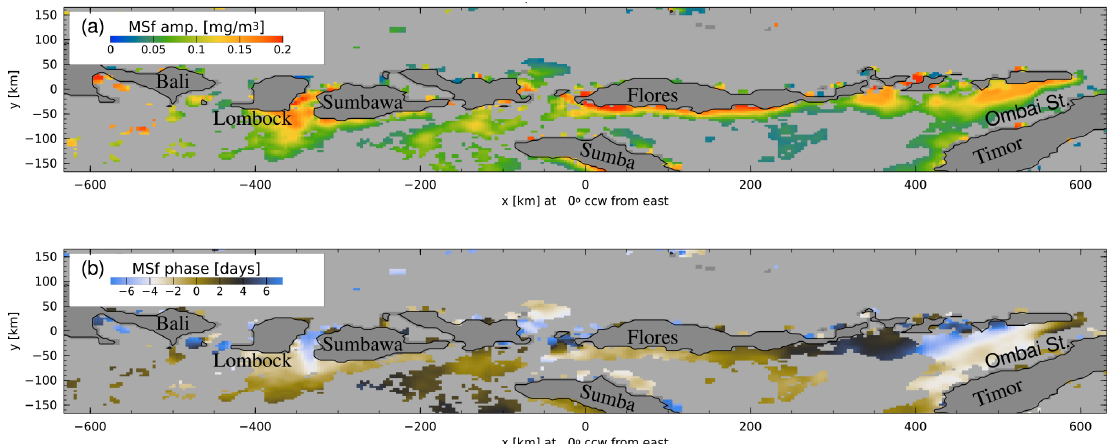
Figure 5. (a) Amplitude and (b) phase of the fortnightly MS f harmonic constants of Chl a along the Lesser Sunda Islands, from Bali to Ombai Strait (indicated in Fig.